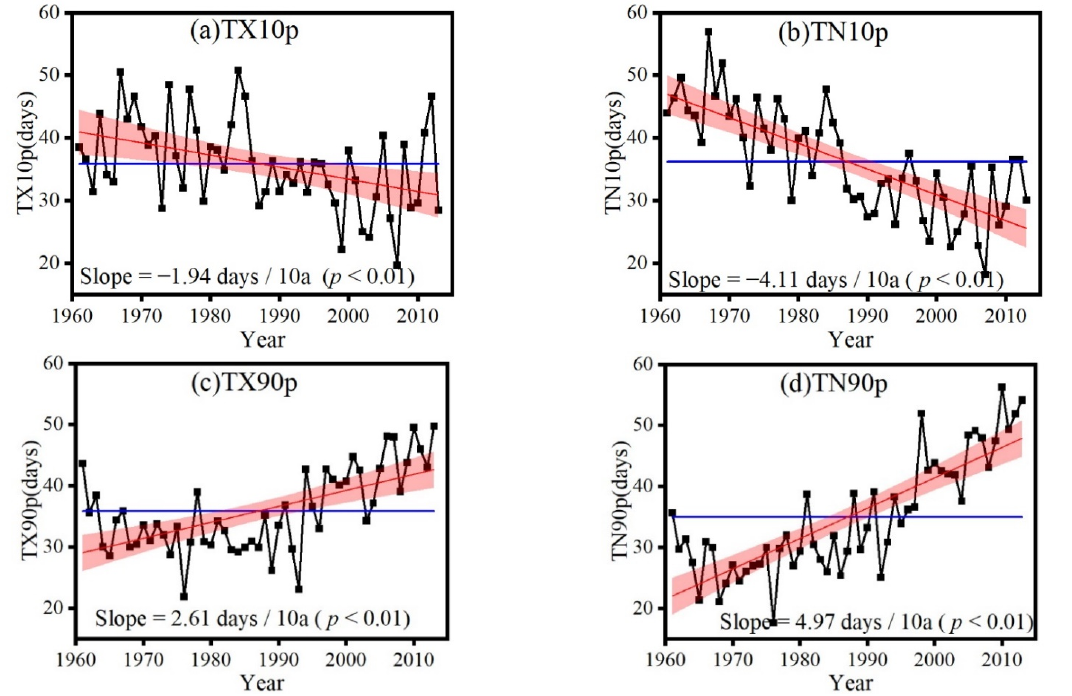
Figure 2. Interannual trends of ( a ) TX10p, ( b ) TN10p, ( c ) TX90p, ( d ) TN90p in mainland China from 1961 to 2013. The black line represents the extreme temperature indices series, the red line represents the trend, the transparent red band indicates a 95% confidence interval, and the blue line represents the mean value.